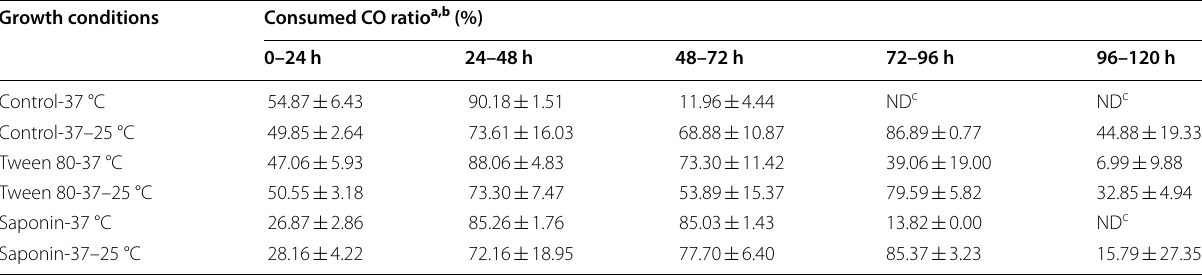
a Mean values and standard errors of three replicates are shown b The ratio of the consumed to the renew of CO every 24 h c ND represents the CO consumption was not detected